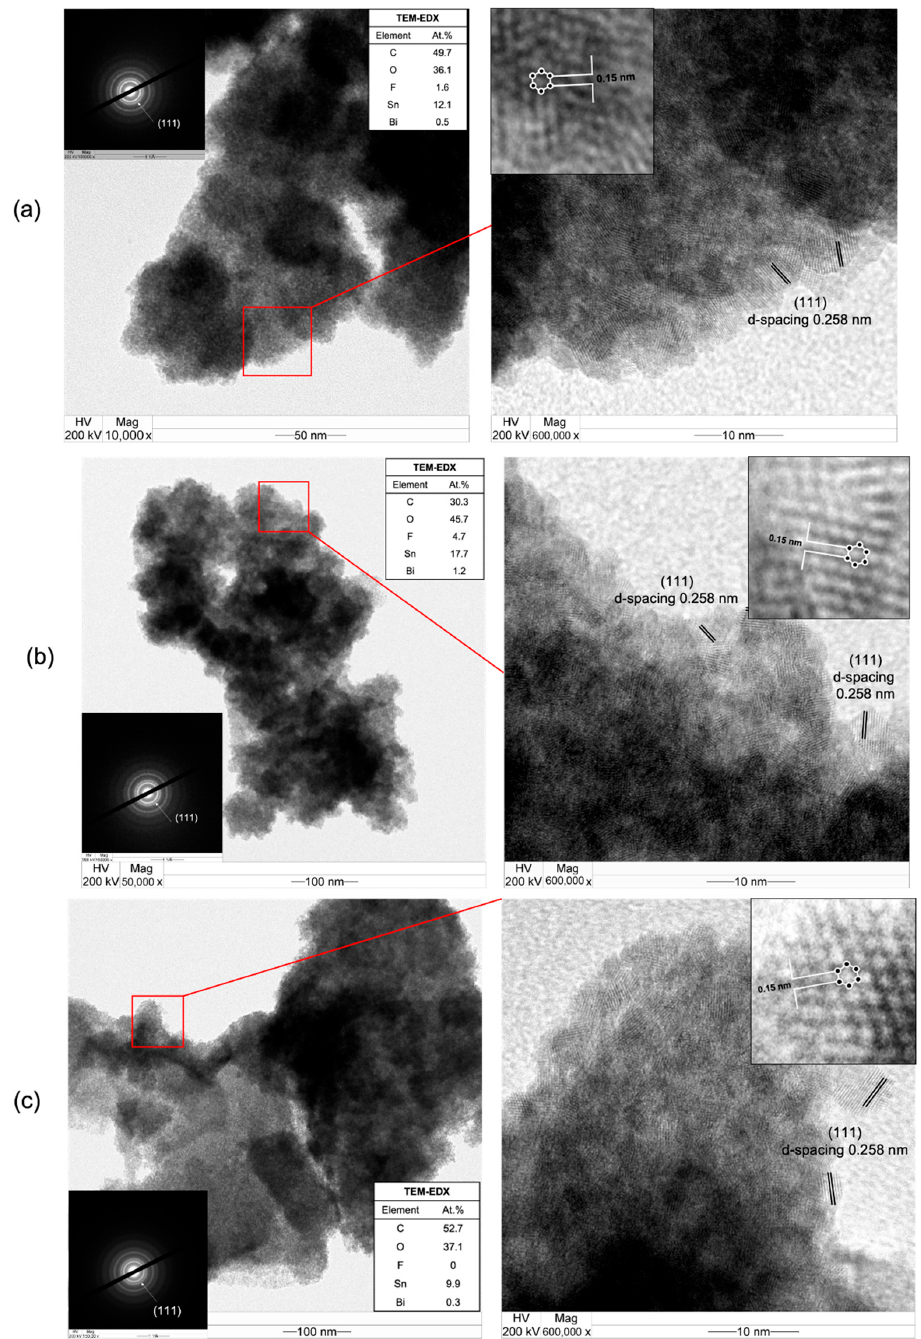
Figure 7 . The TEM-SAED-EDX results of ( a ) 0.01Bi/Sn, ( b ) 0.05Bi/Sn, and ( c ) 0.1Bi/Sn electrodes after CO 2 RR test at − 1.1 V vs. Ag/AgCl .